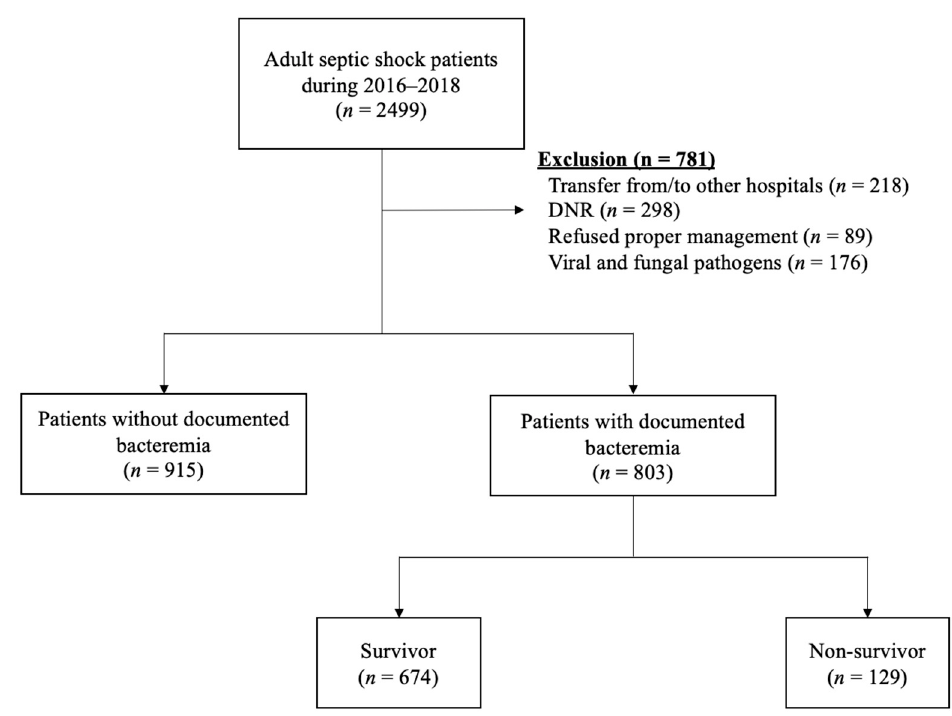
Figure 1. Flowchart of the study population. Abbreviations: DNR = Do not resuscitate. The baseline characteristics of our final study population according to the 28-day mortality outcomes (i.e., survivors and non-survivors) are presented in Table 1. There were no differences in gender or age between the survivor and non-survivor groups. No differences in comorbidities were found either other than coronary artery disease (8.8